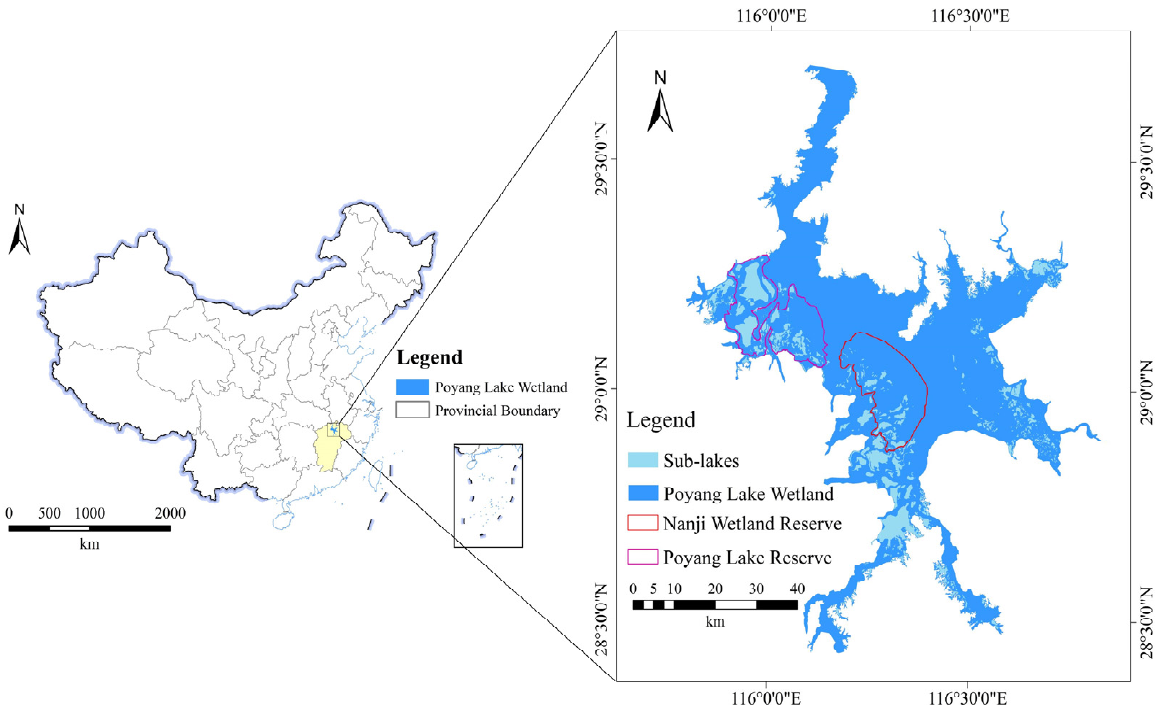
Figure 1. Locations of Poyang Lake wetland, sub-lakes, and two national nature reserves.